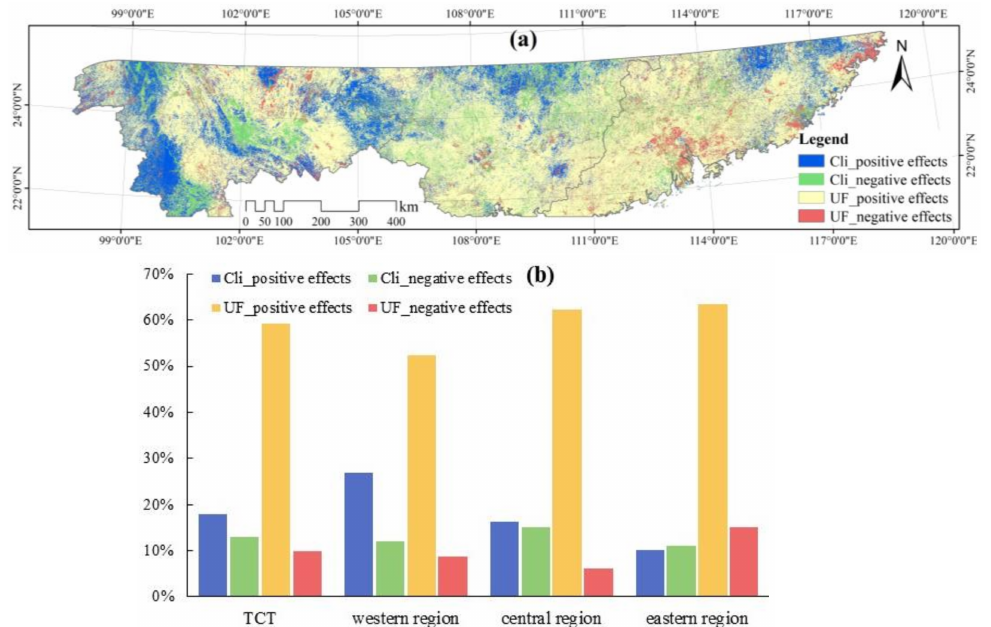
Figure 5. ( a ) Effects of climate variability and anthropogenic activities on NPP in the TCT and the three regions and ( b ) the corresponding percentage contribution. Cli_positive effects and Cli_negative effects, UF_positive effects and UF_negative effects represent positive and negative effects of climate variability and anthropogenic activities on NPP,